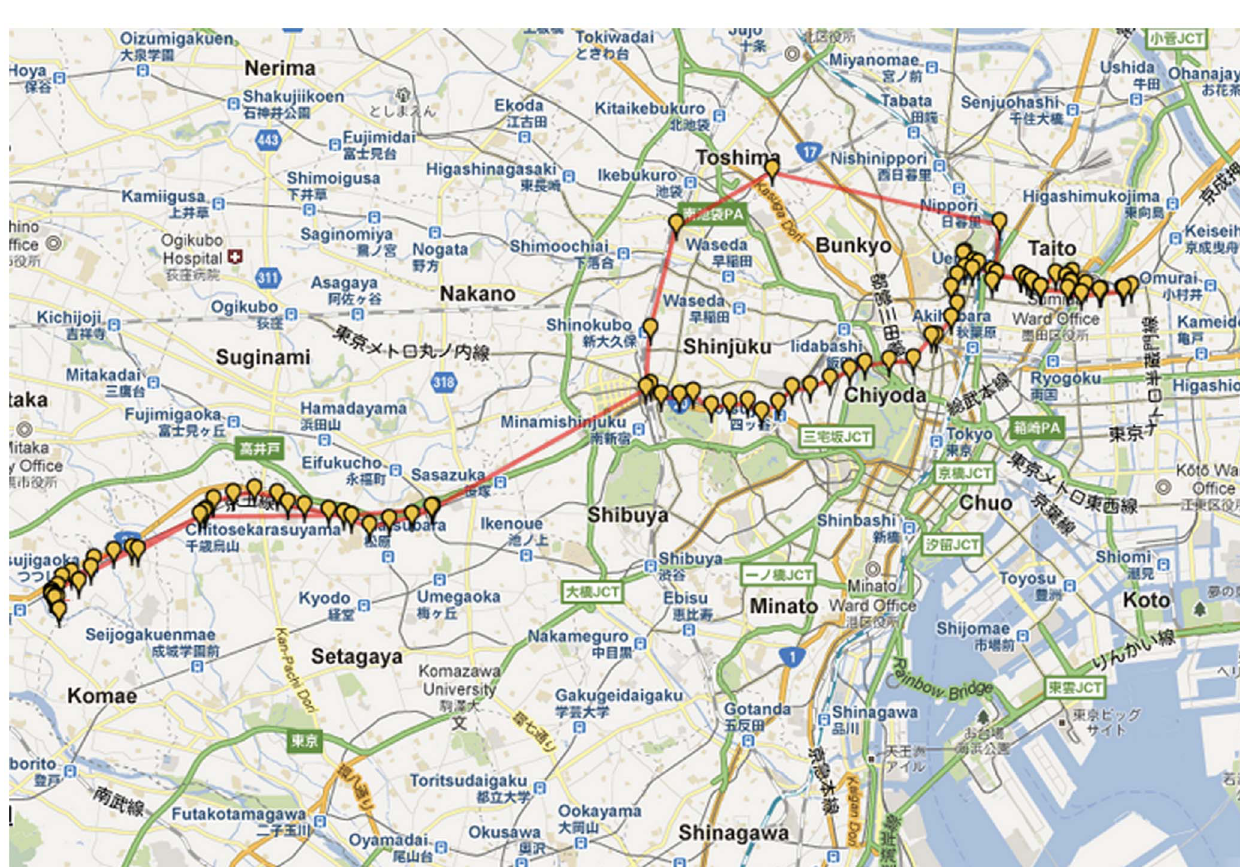
Figure 2. An example of a mobile phone user’s location traces.